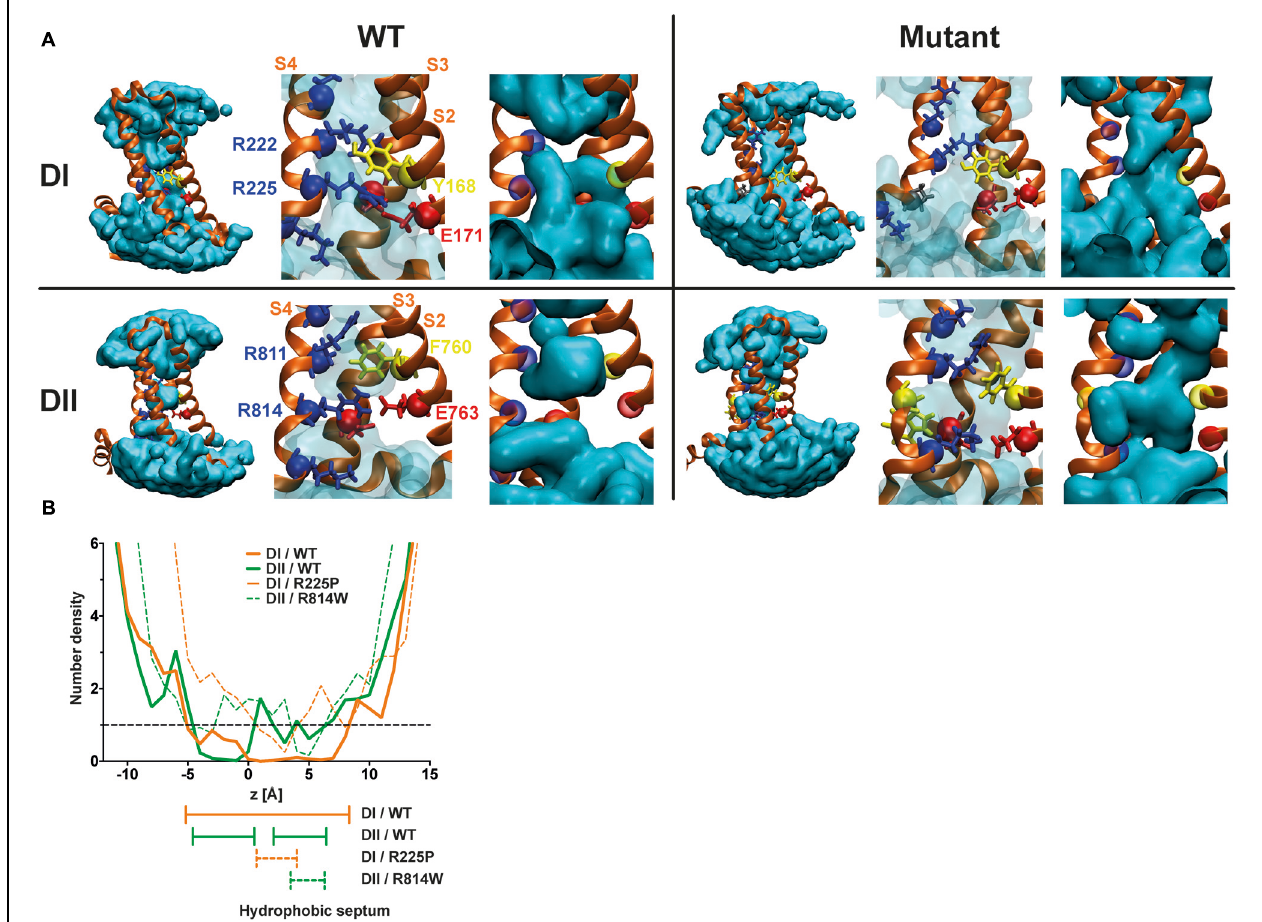
FIGURE 6 | Molecular basis for the creation of gating pores. (A) Models of the DI and DII of Na v 1.5 were built based on previously published results (Moreau et al., 2015). The top row shows the DI models. The bottom row shows the DII models. The left panels represent WT VSDs and the right panels represent mutant VSDs (top R225P, bottom R814W). The protein is shown as orange ribbons, and the water crevice is shown in blue. Positively charged residues in the S4 segment and residues making up the GCTC are highlighted. Positively charged residues are depicted in blue, negatively charged residues in red, aromatic residues in yellow, and the proline in gray. The complete VSD is shown (left) for each panel. A higher magnification of the GCTC is also shown to clearly see the interactions between the S4 segment and the GCTC (middle) as well as the merging of the water crevices from both sides of the membrane (right) for the mutant channels. For purposes of clarity, the S1 segment has been removed. (B) Water density profiles of the Na v 1.5/DI (orange) – DII (green) WT and R225P – R814W mutant channels (dash lines). The histograms were built using a 1-A grid, and the averages were calculated from at least 6 ns of the trajectories. 0 corresponds to the position of the C α of Y168 of S2 (DI) or the position of the C α of F760 of S2